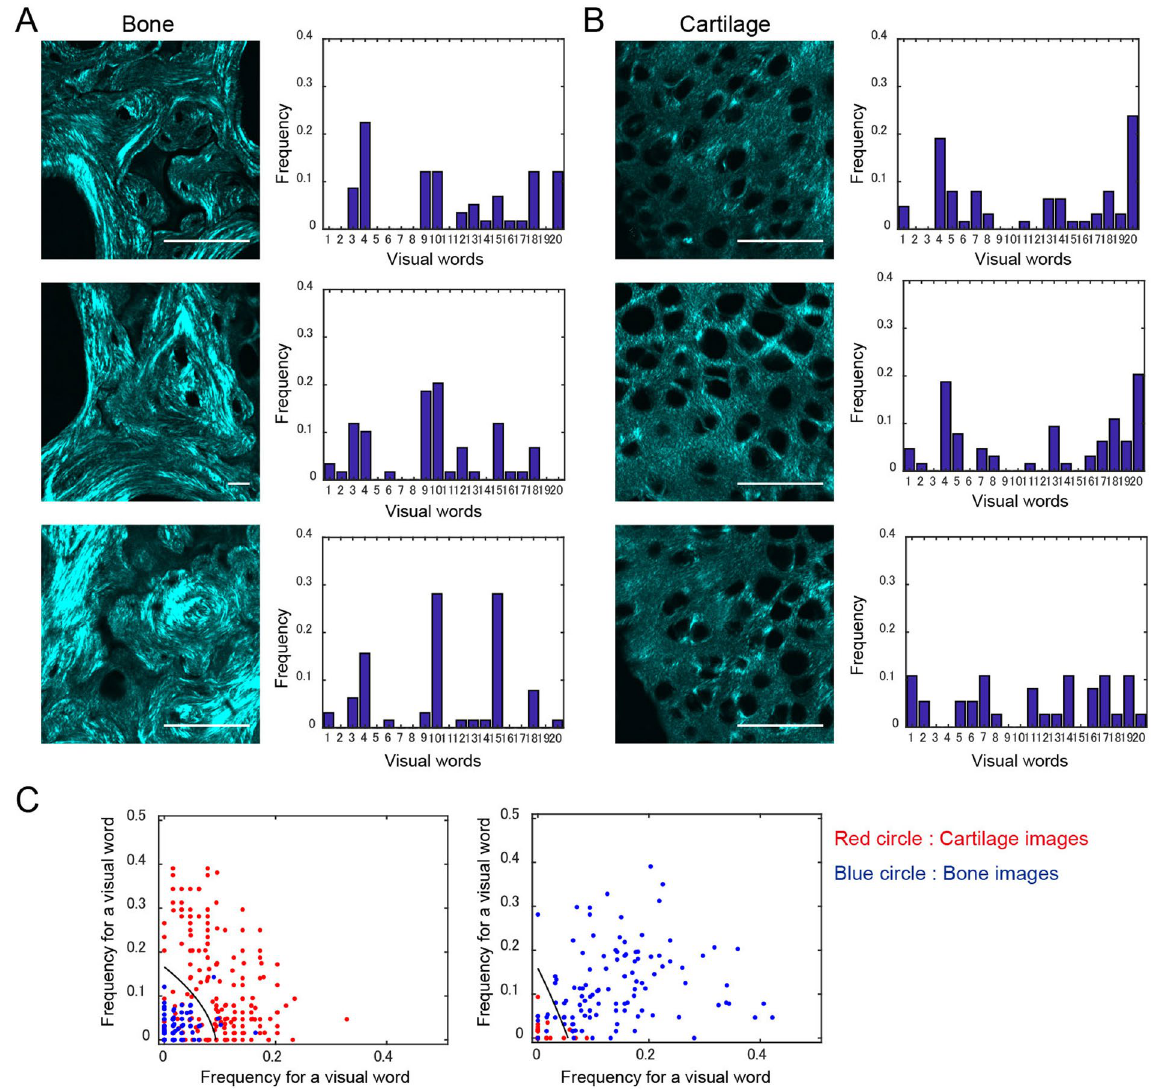
results exhibited are k = 20 case. ( C ) Results of the training data set. The classifier was constructed by the SVM machine learning method. Scale bar: 50 μ